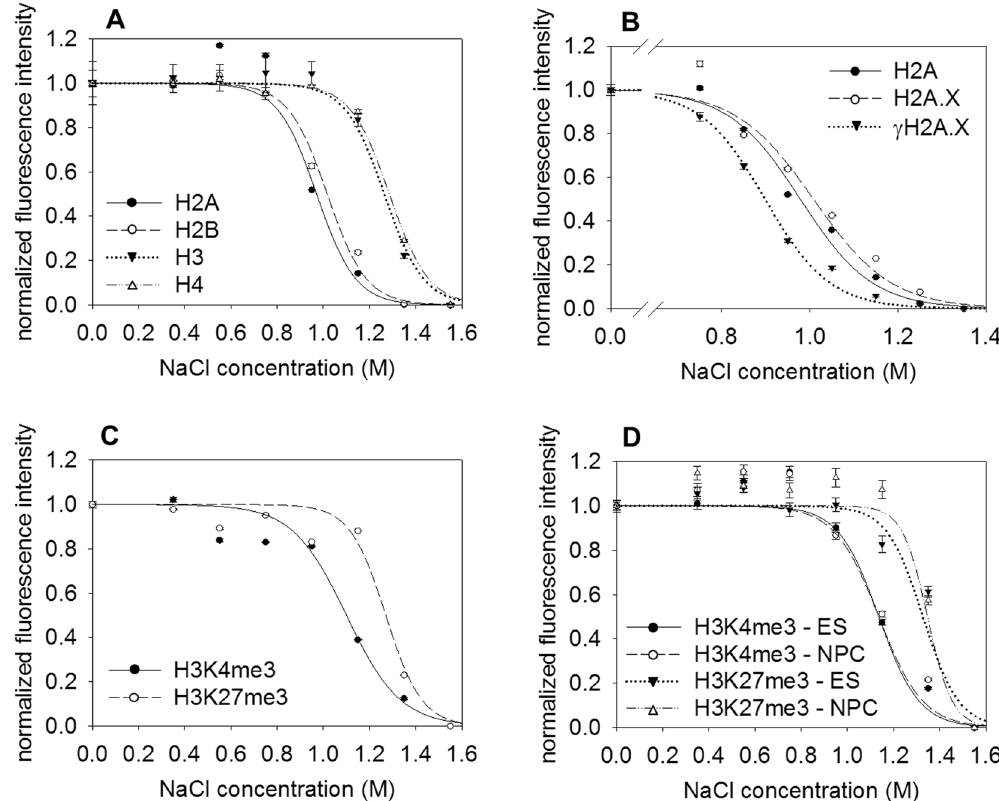
Figure 3. Salt induced nucleosome destabilization. ( A ) Salt elution profiles of antibody detected H2A, of H2B-GFP, H3-GFP and H4-GFP in histone-GFP expressor HeLa nuclei. ( B ) Salt elution profiles of γ H2A.X, H2A.X and H2A, measured in parallel, in the nuclei of HCT116 cells exposed to 25 μ M etoposide. (See also: Supplementary Fig. S6). ( C ) Salt elution profiles of H3K4me3 and H3K27me3 in HeLa nuclei. (See also: Supplementary Fig. S7). ( D ) Salt elution profiles of H3K4me3 and H3K27me3 in mES and NPC nuclei (See also: Supplementary Fig. S2). The elution curves refer to G1 phase cells gated according to their DNA fluorescence intensity distribution and the error bars represent SEM of ~600 G1 nuclei measured by LSC. The cell-to-cell and sample-to-sample C.V. values of the elution profiles are shown in Supplementary Table